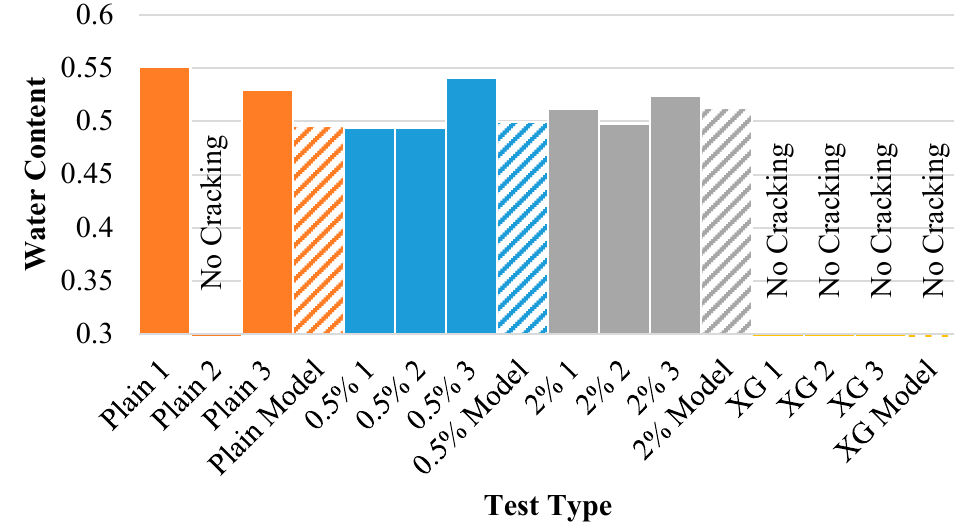
Figure 18. Water content at wall crack initiation for each of the experiments and model results.